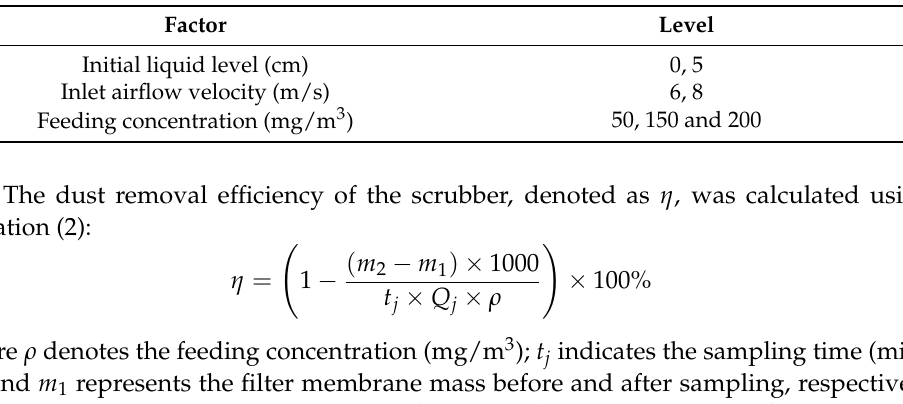
Table 3. Factors and levels considered in the experimental